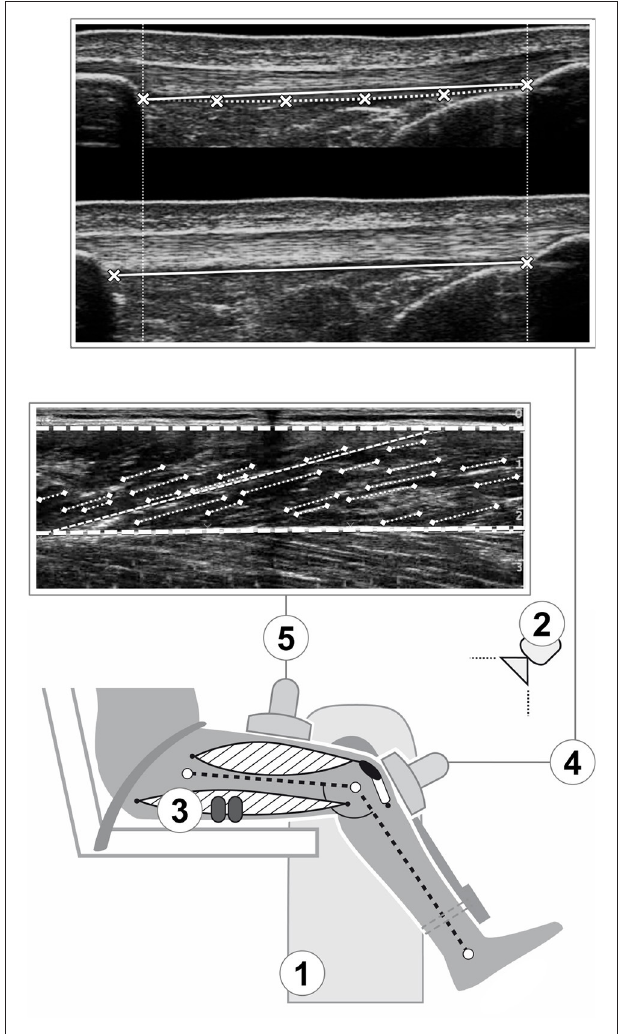
FIGURE 1 | Schematic representation of the experimental setup. A dynamometer (1) was used to measure knee joint moments, while kinematic recordings (2) were used for inverse dynamics and electromyography (3) for the consideration of antagonist coactivation. Ultrasound imaging was integrated to assess patellar tendon elongation (4; the crosses indicate the reference points at the deep insertion sites and lower border of the tendon used for measuring elongation and rest length respectively; see methods section for details) and vastus lateralis architecture (5; the digitalization of the aponeuroses and the fascicle portions, indicated by the thick dashed line and pointed lines respectively, and the calculated reference fascicle, represented by the thin dashed line, are overlayed over the ultrasound